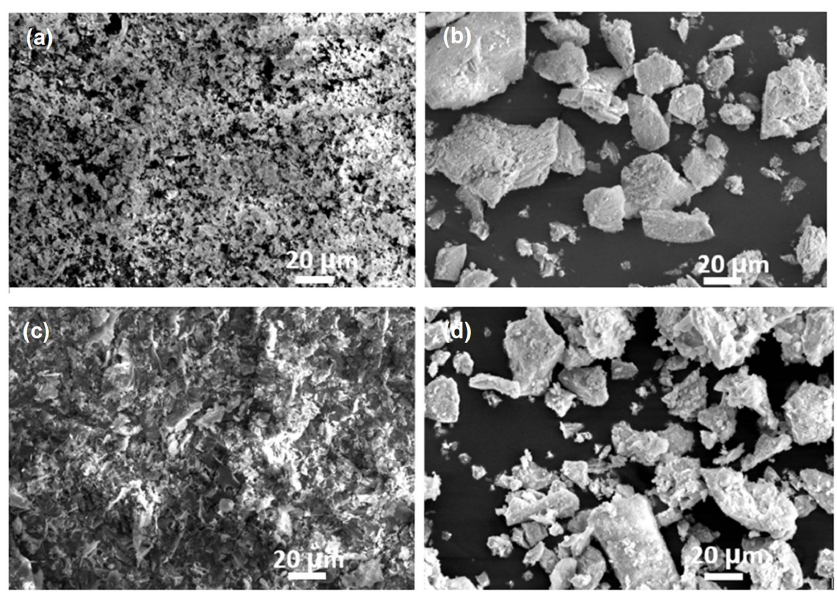
Figure 1. SEM micrographs of ( a ) C-La 2 O 3 , ( b ) CP-La 2 O 2 CO 3 ( c ) SG-La 2 O 2 CO 3 and ( d ) HT- La 2 O 2 CO 3 . Magnification is 250 × collected with an acceleration voltage of 20 kV. The basicity of the catalyst was analysed using TPD-CO 2 from 30 to 900 ◦ C. The data Table 1. BET surface area, pore volume, average pore diameter and total number of basic sites of the catalysts. Catalyst